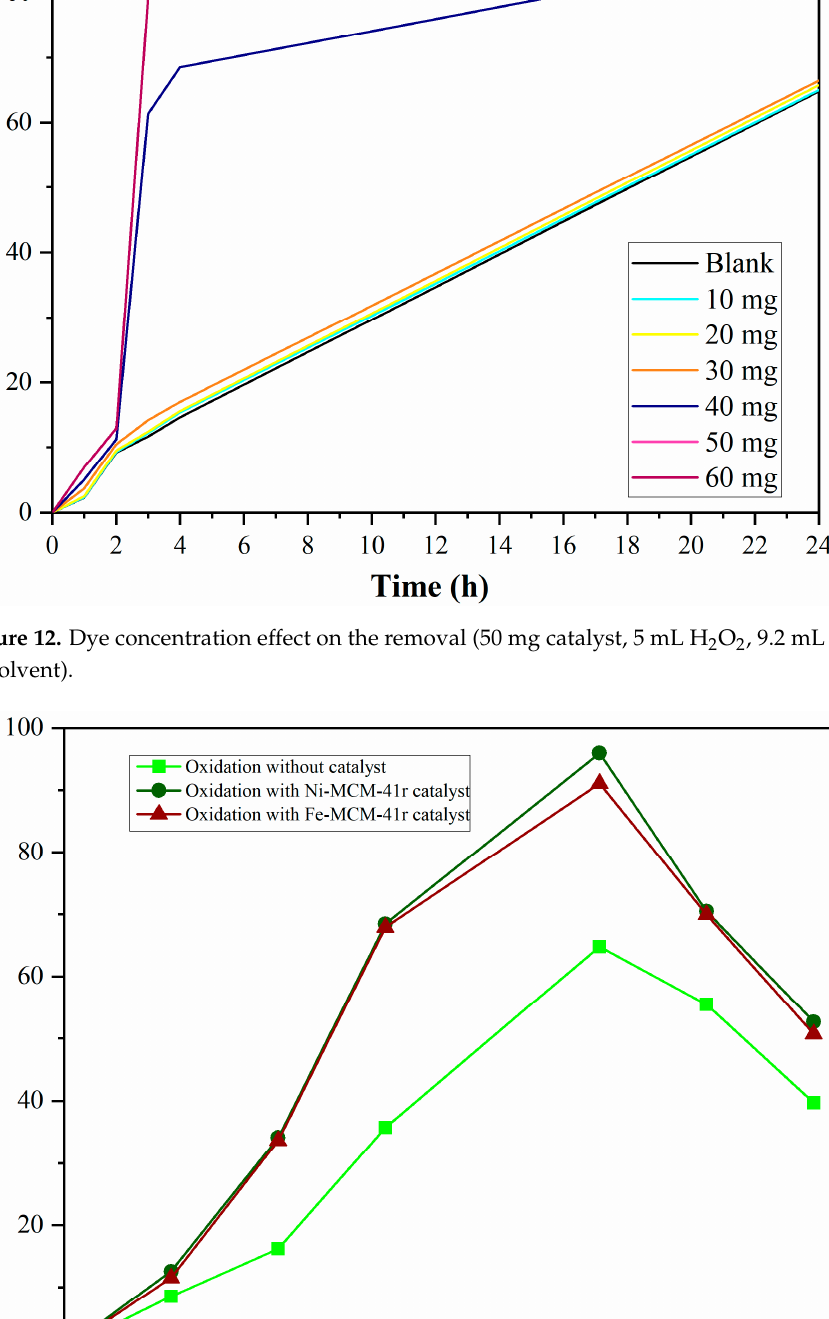
Figure 13. Catalyst dosage effect on removal efficiency (5 mg/L dye, Fe-MCM-41 r as catalyst, 5 mL H 2 O 2 , 9.2 mL acetonitrile as solvent).